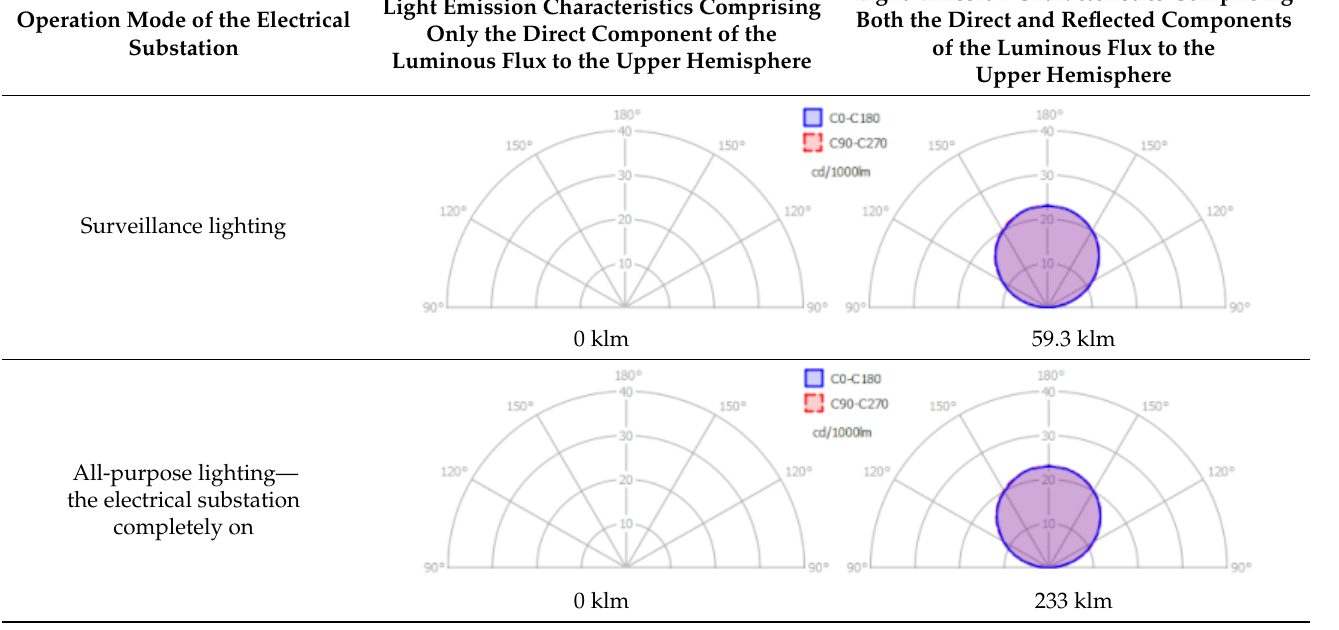
Table 6. Light emission characteristics of two operational modes of the electric station TR Prosenice after refurbishment.